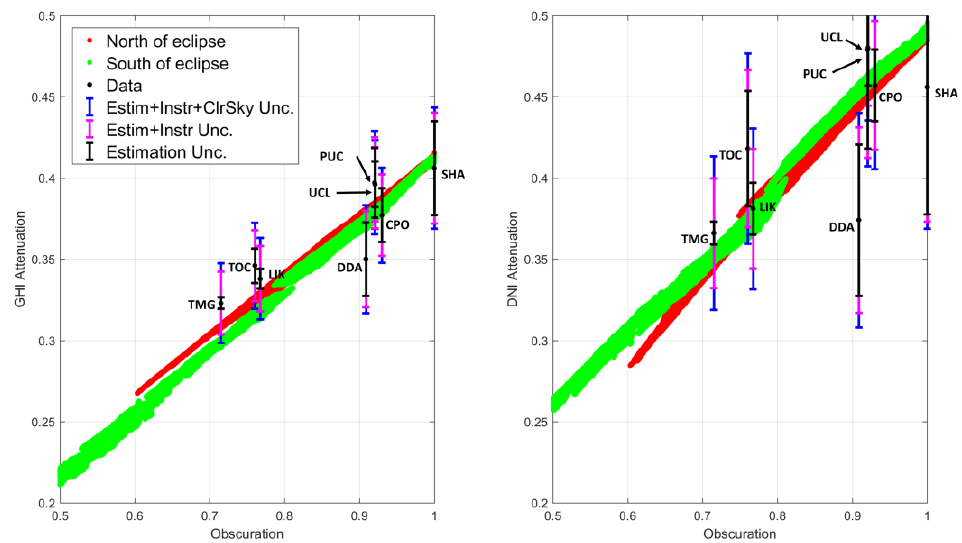
Figure 15. Estimated attenuation as a function of local obscuration, calculated for the Chilean mainland territory. Uncertainty interval considers proposed method error and clear sky and instru- mentation